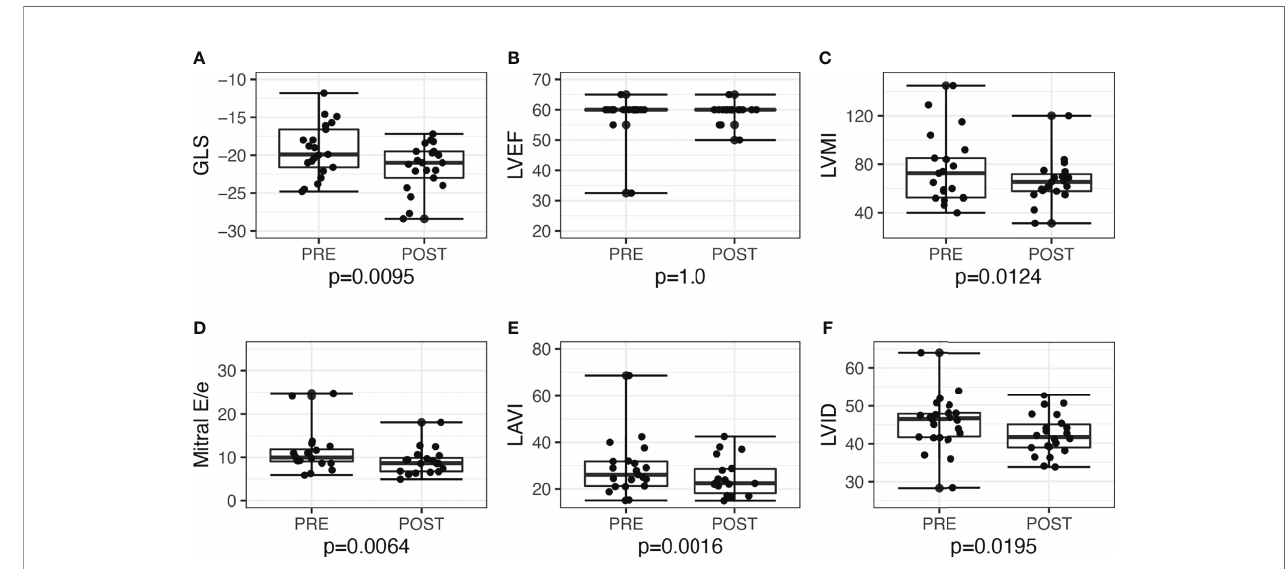
FIGURE 2 | Echocardiographic parameters before and after adrenalectomy among patients with unilateral primary aldosteronism (n = 21). Improvement of left ventricular systolic function seen when assessed with (A) global longitudinal strain (GLS), but not with (B) left ventricular ejection fraction (LVEF). Improvements seen post-adrenalectomy in other parameters as well: (C) left ventricular mass index (LVMI); (D) mitral E/e ’ ; (E) left atrial volume index (LAVI); (F) left ventricular internal dimension (LVID).